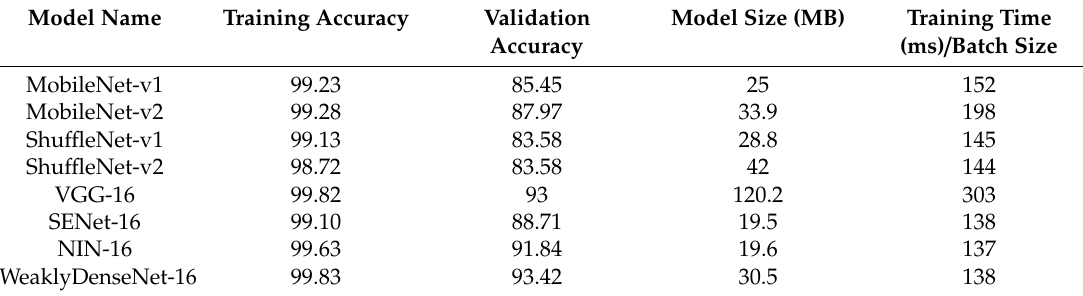
Table 4. Training performance of selected